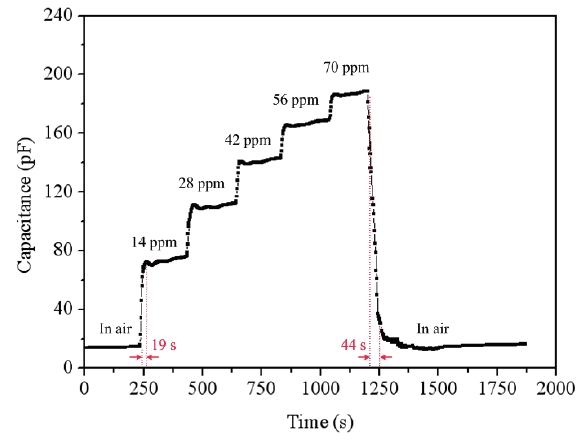
Figure 12. Reaction of the acetone sensor at 0–70 ppm acetone.